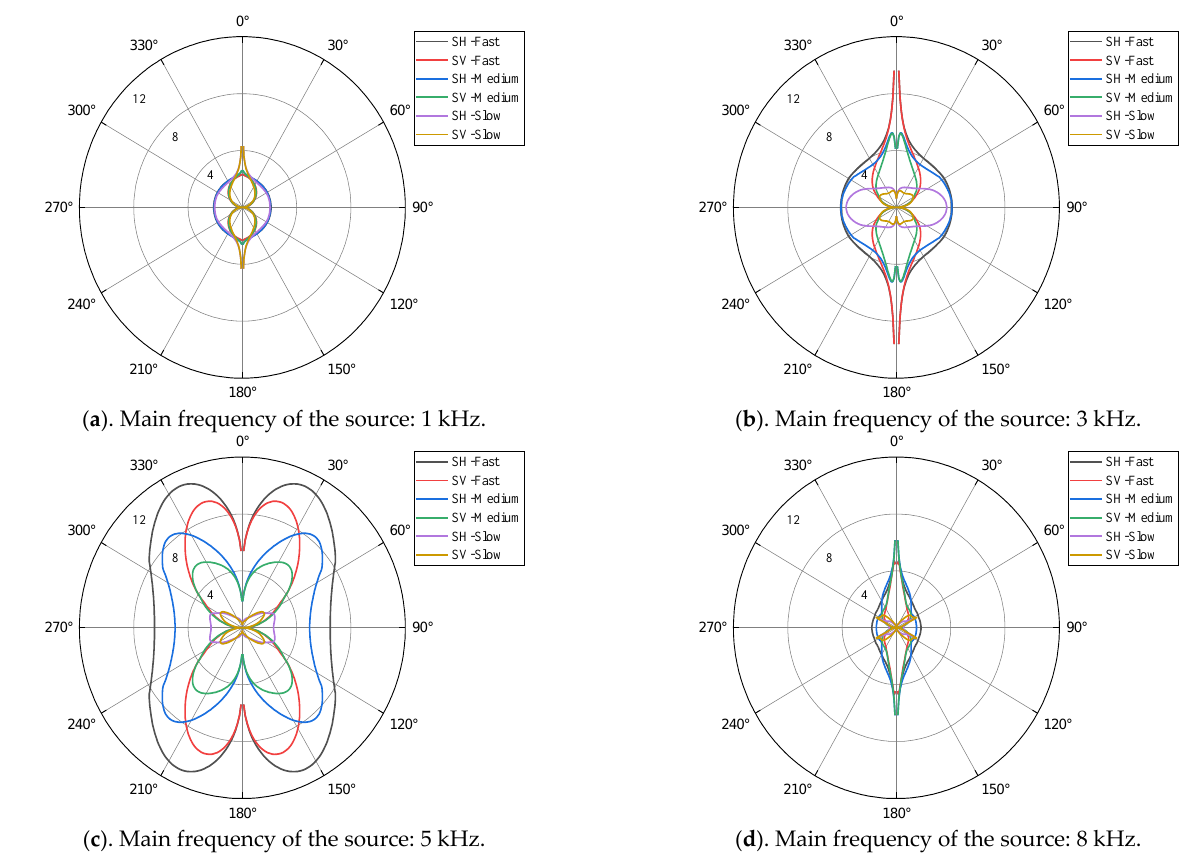
Figure 7. Radiation characteristics of SH–wave and SV–wave of a dipole source in different formations under different main frequencies.